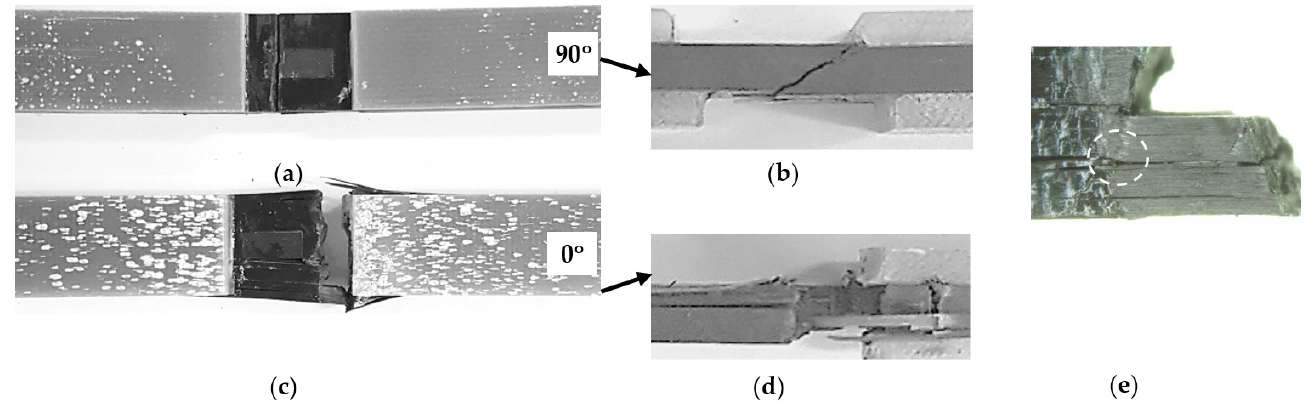
Figure 5. Stress–strain curves in compression mode for different orientations; ( a ) 0°; ( b ) 90°. Table 2. Mechanical properties in compression mode of uniform coupons for the two orientations.